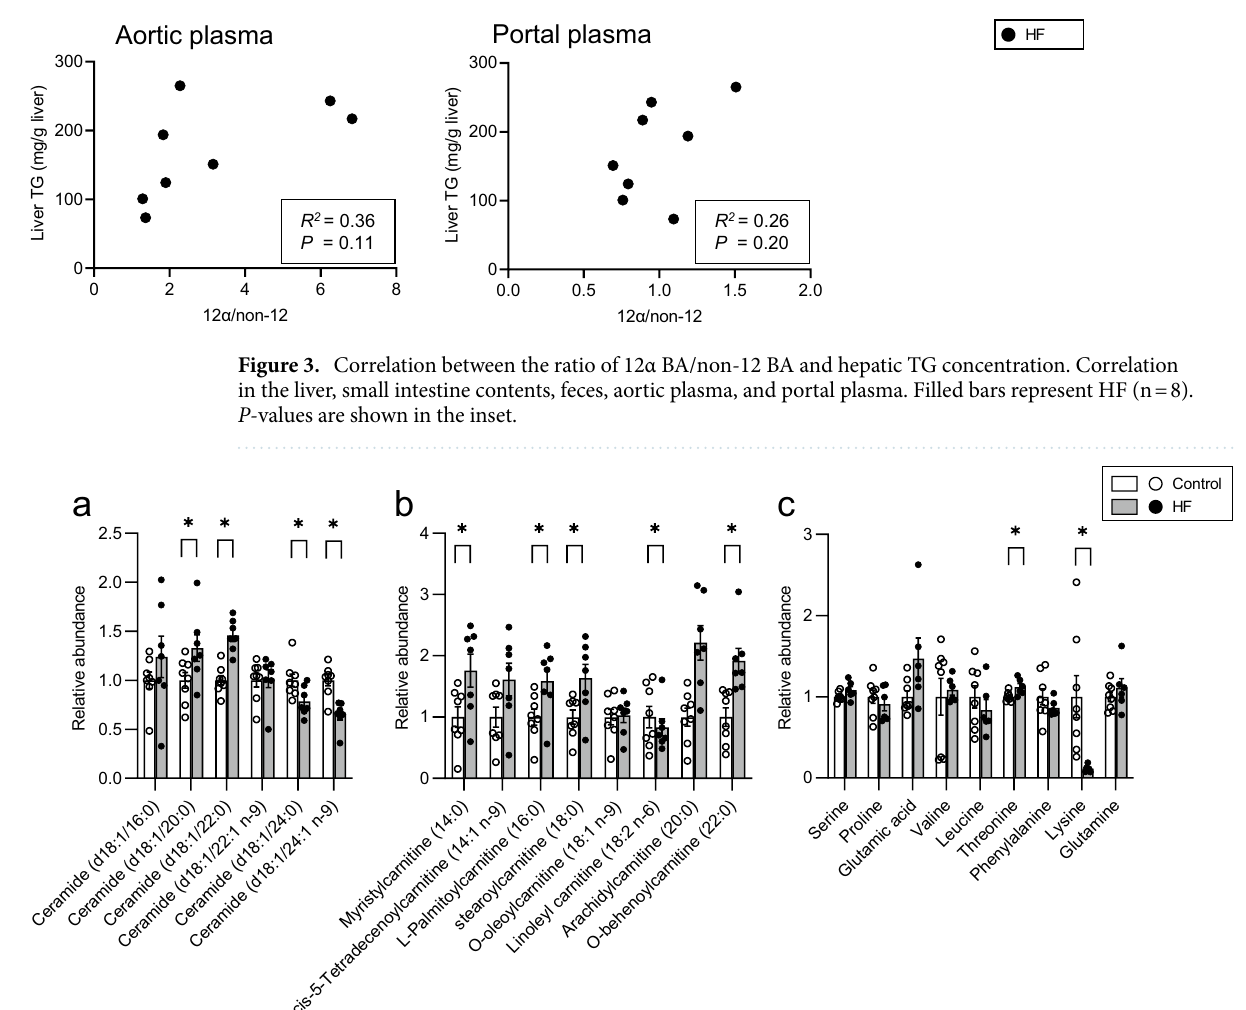
Figure 4. Composition of various metabolites in the liver of the mice fed control and HF diet. Relative abundances of ceramides ( a ), acylcarnitine ( b ), and amino acids ( c ). Open bars represent control (n = 8) and filled bars represent HF (n = 8). Values are shown as mean ± SEM (n = 8). Asterisks indicate a significant difference compared with the control ( P <